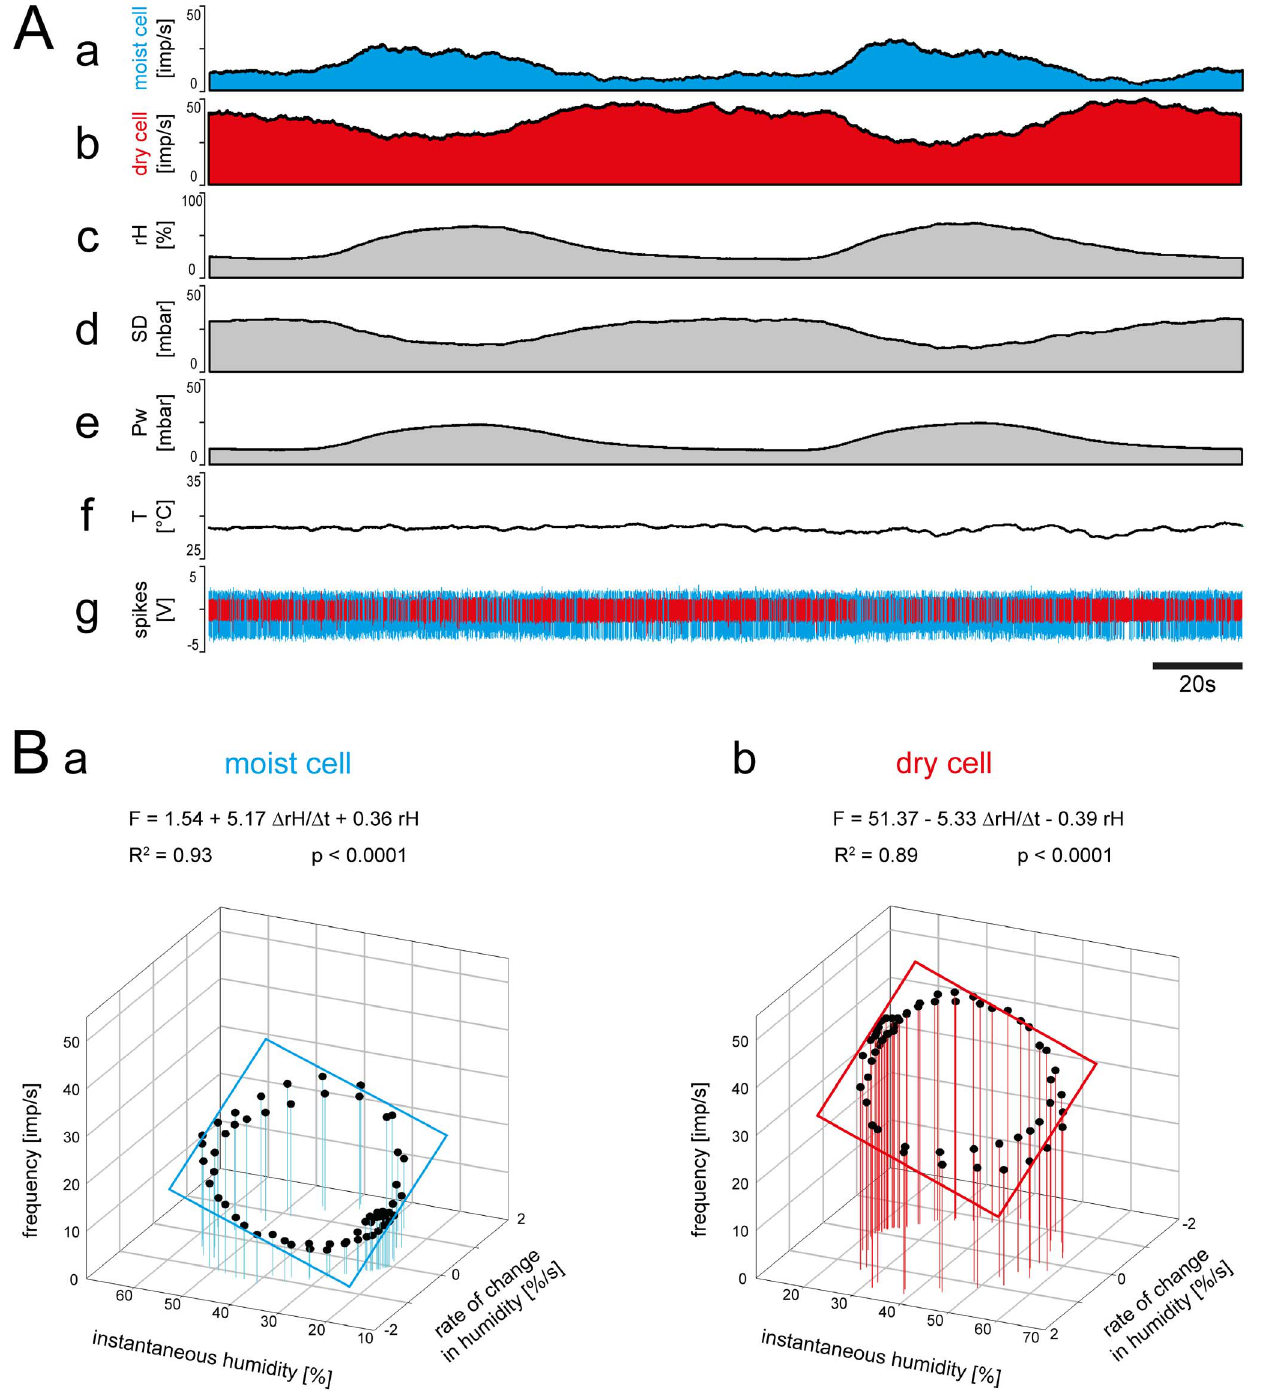
Figure 5. Simultaneously recorded responses of a pair of moist and dry cells from a single sensillum to high amplitude changes in humidity. A. Time course of the responses and the parameters controlled during the recording, and the corresponding activity of the moist and dry cells. a and b , instantaneous impulse frequency of both cells. c , time course of the relative humidity. d , time course of the saturation deficit. e , time course of the water vapor pressure. f , time course of the temperature. g , digitized action potentials of the moist and dry cells recorded with a single electrode and discriminated on-line. B. Impulse frequency of the moist and dry cells during the oscillations in relative humidity shown in A plotted as a function of instantaneous relative humidity and its rate of change. Multiple regressions which utilize 3-dimensional planes ( F = a + b drH/dt + c rH ; where F is the impulse frequency, and a the height of the regression plane) were calculated to determine the simultaneous effects of the rate of change in the relative humidity ( b slope) and the instantaneous relative humidity ( c slope) and the response frequency of both cell types. Pw water vapor pressure, R 2 coefficient of determination, rH relative humidity, SD saturation deficit, T temperature, V volt.